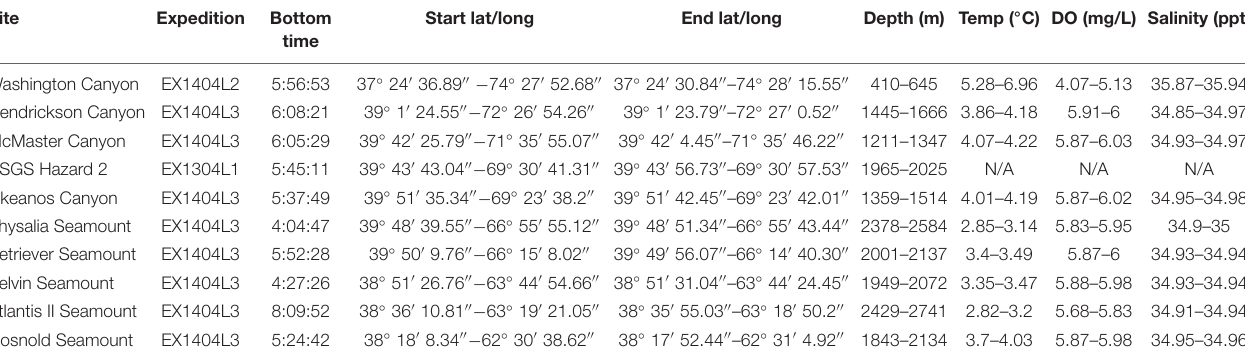
FIGURE 2 | Individuals from the phylum Porifera plotted along a segment of the ROV track on Retriever Seamount. Top right corner: full ROV track plotted over 50 m contour lines and bathymetry. TABLE 1 | Description of all sites analyzed in this study along with ranges of depth (m), temperature ( ◦ C), dissolved oxygen (mg/L), salinity (ppt) observed at each dive